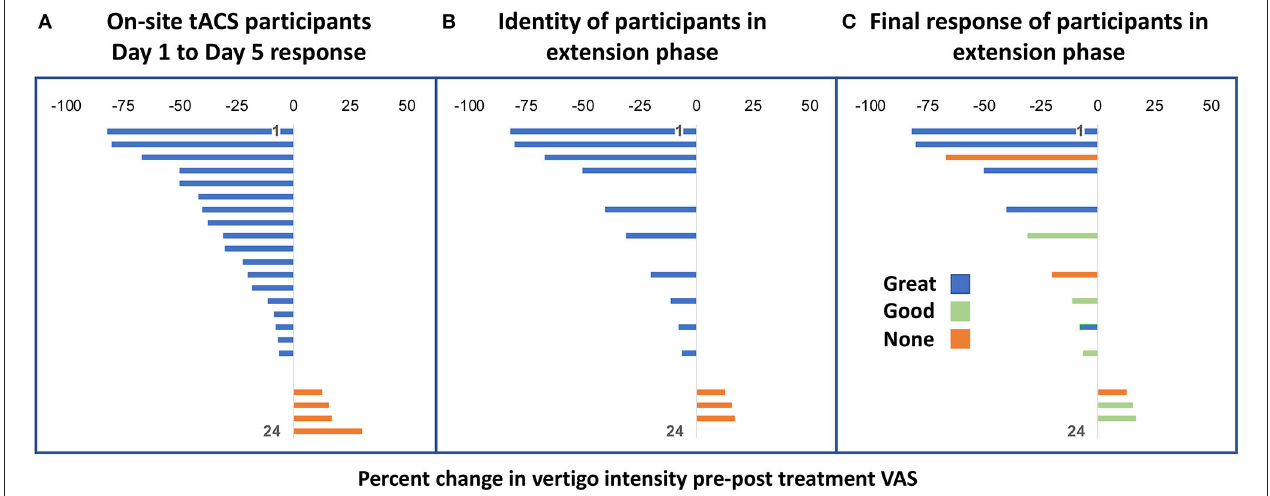
FIGURE 3 | (A) Percentage change of oscillating vertigo intensity from Day 1 to Day 5 of on-site tACS treatment of 24 participants. (B) Identity of the 13 participants in the extension phase from within the on-site group of 24 participants. (C) Final treatment response of the 13 participants as “Great,” “Good,” or “None” shown in relation to their original response level from their on-site